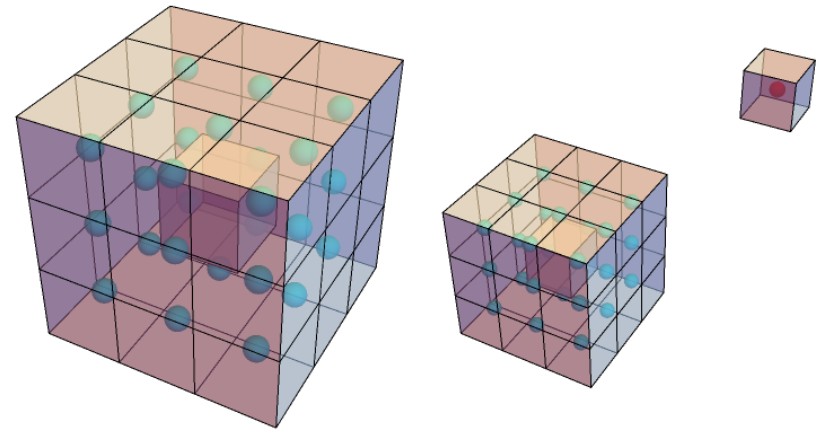
Figure 14: For the left configuration, the number of domains of up spins is n ↑ = 1, and the number of domains of down spins is n ↓ = 2; the number of domain wall = max ( n ) = 2. For the right one, this relation fails. Different components is n ↑ , n ↓ dw clusters of up spins are colored